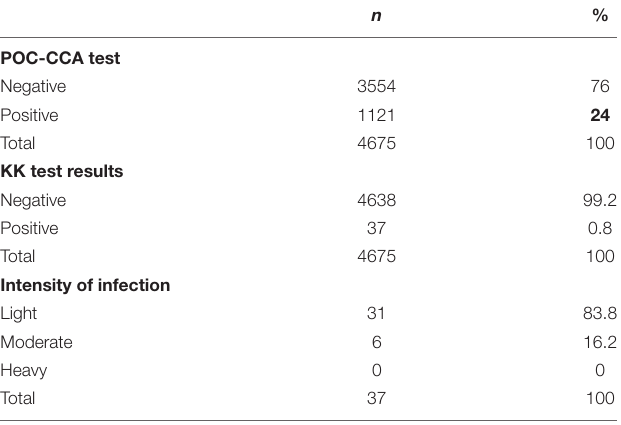
TABLE 3 | Prevalence and infection intensity of the study population. n %